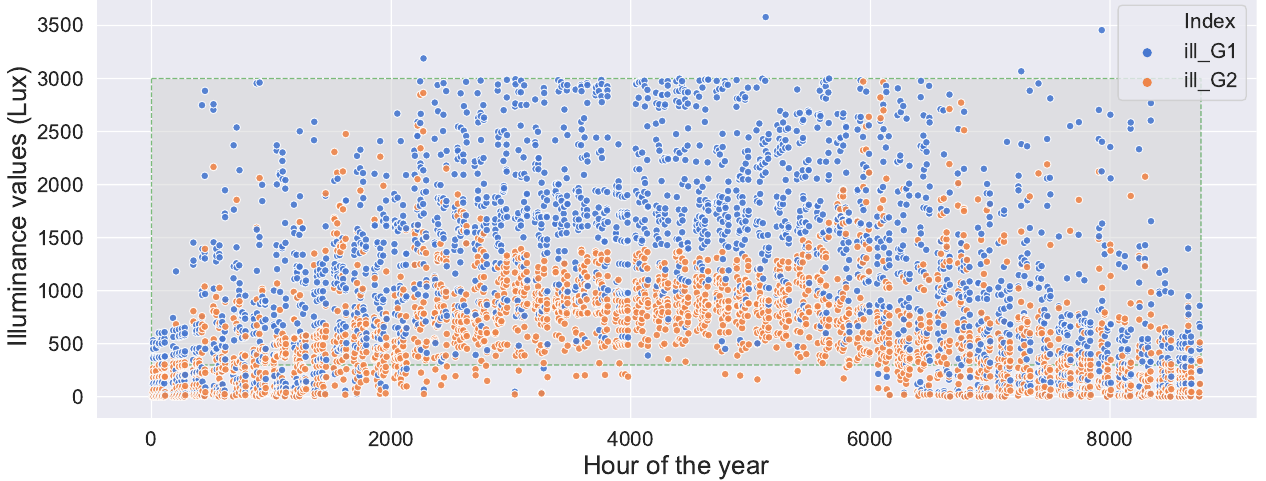
Figure 18. Illuminance values obtained with the DQN agent suggested combinations over a year.